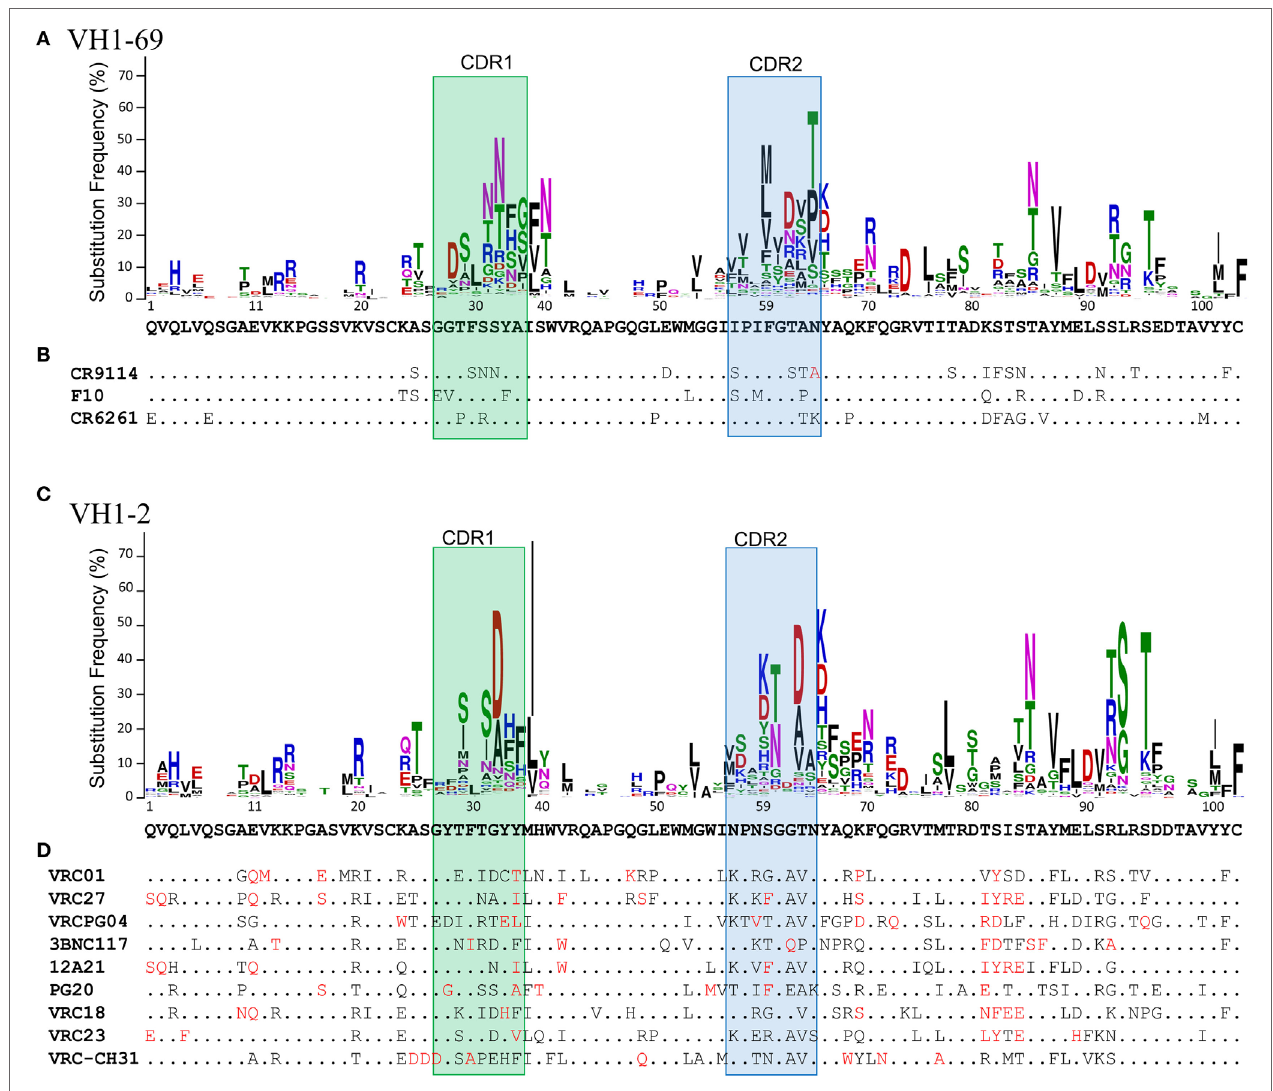
FigURe 1 | Substitution profiles and the accumulation of rare mutations. (A) Substitution profile of VH1-69 as calculated by Sheng et al. (33). The germline amino acid sequence is shown below the logo plot. (B) Sequence alignment of VH1-69-derived influenza antibodies capable of neutralizing multiple subtypes. Dots indicate the germline amino acid and extremely rare substitutions [as defined in Ref. ( 33)] are shown in red. (C) Substitution profile of VH1-2. (D) Sequence alignment of VH1-2-derived broadly neutralizing HIV antibodies targeting the CD4 binding site. Each contains greater than ~20% or more extremely rare